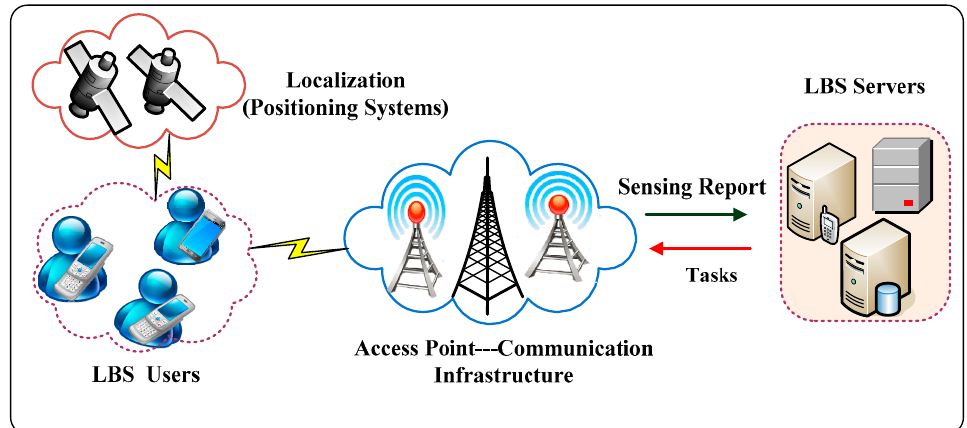
Figure 1. The common location-based service (LBS) system deployment scenario: LBS servers, localization, communication networks, and mobile users .